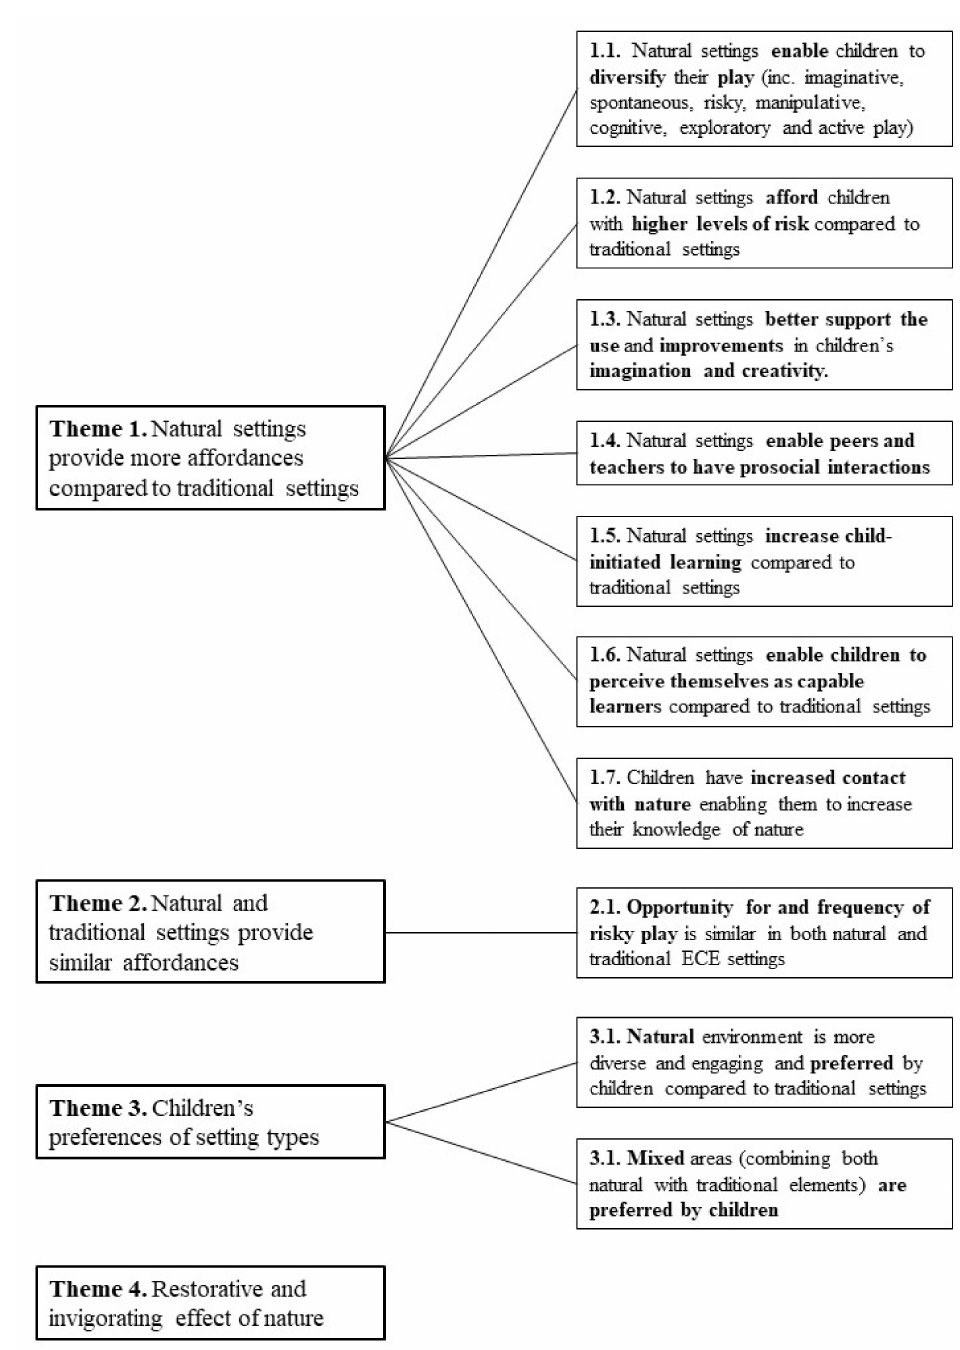
Figure 6. Findings from the thematic